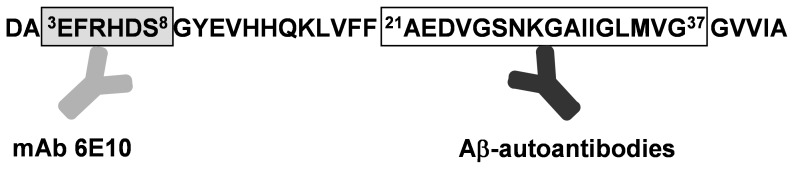
Epitope specificities of the coating antibody (mAb 6E10) and the Aβ-autoantibodies.